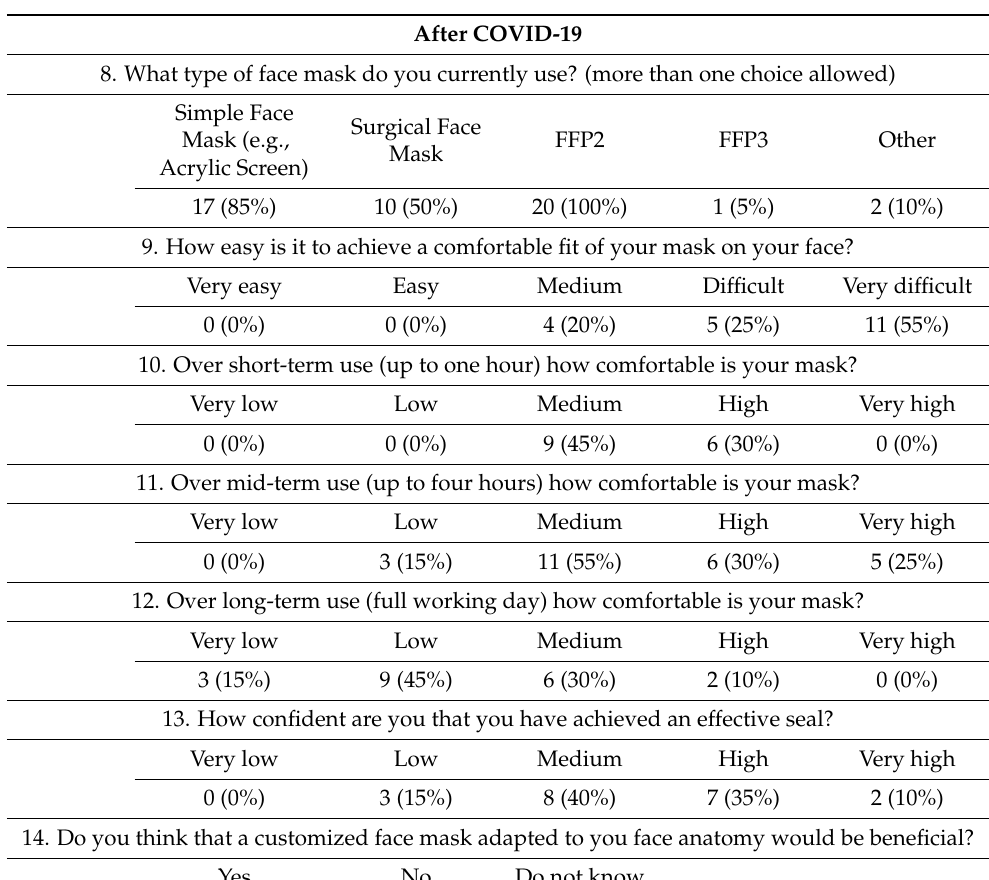
Table 3. Section 3 : After COVID-19.